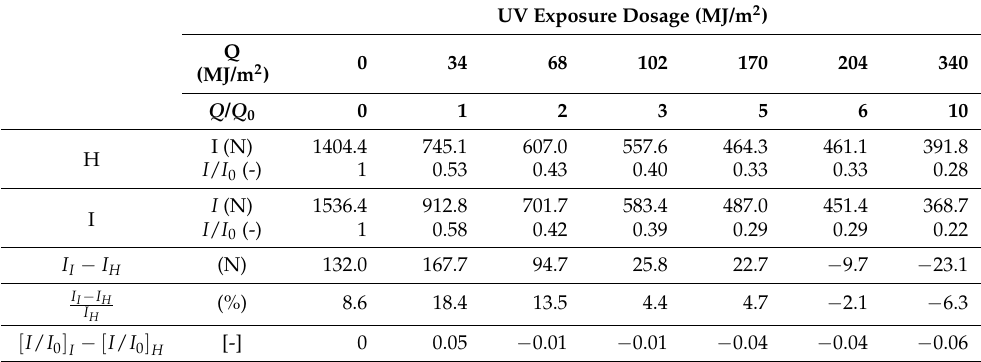
Table 5. Difference of tensile strength affected by mass of fabric (Samples H and I).